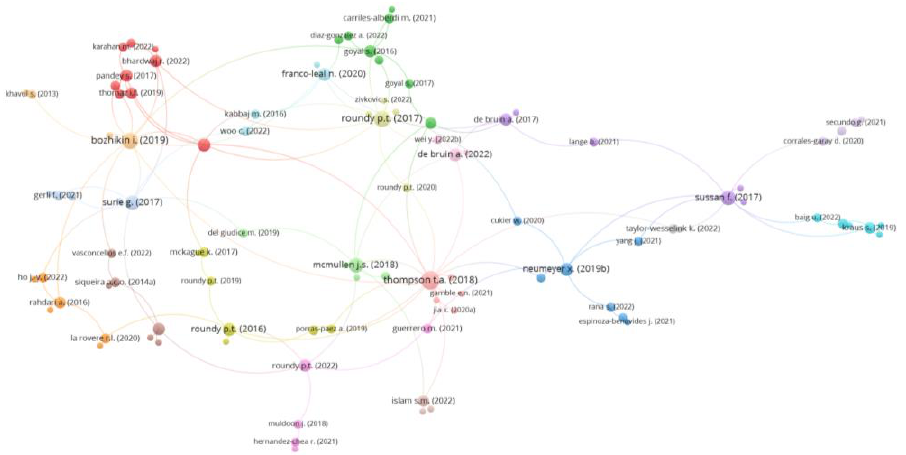
Figure 8. Citation network. Source: authors based on VOSviewer software.